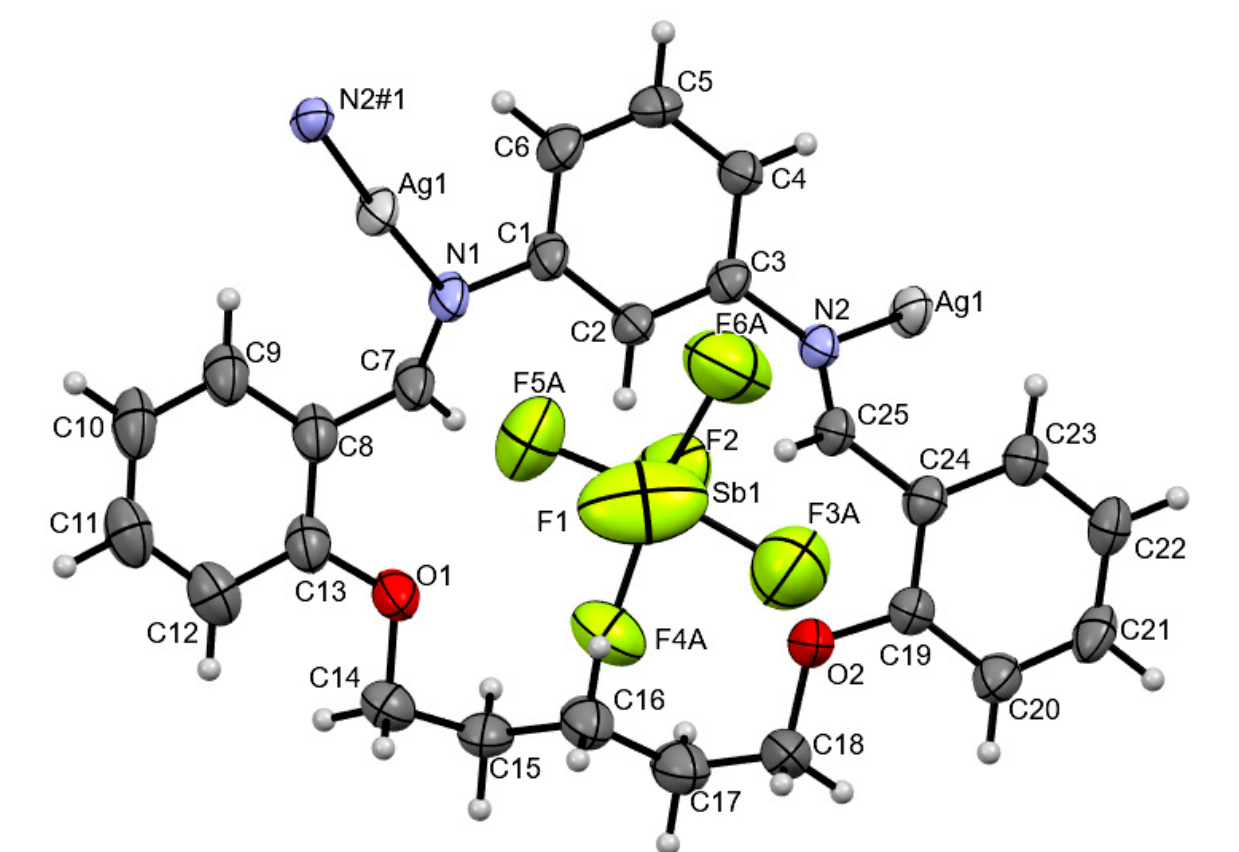
Figure 5. ORTEP plot of AgLSbF 6 with displacement ellipsoids of non-hydrogen atoms drawn at the 50% probability level. Symmetry operation: #1 ½ + x, 3/2 – y, − 1/2 + z. Disordered dichloromethane and chloroform molecules are omitted for clarity.